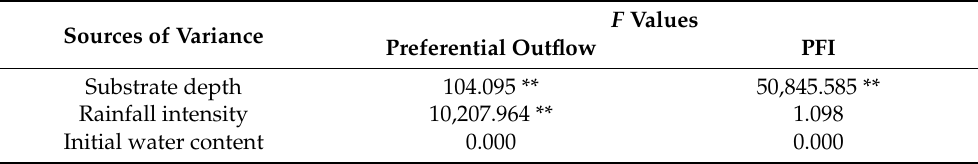
Table 12. Multi-factor ANOVA results for preferential outflow and PFI of